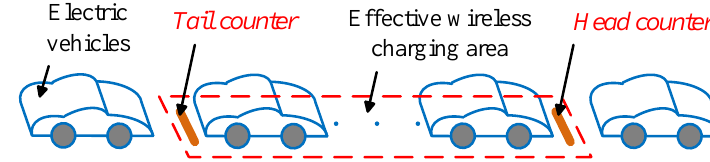
Figure 6. Diagram of the counting method in the effective wireless charging area.